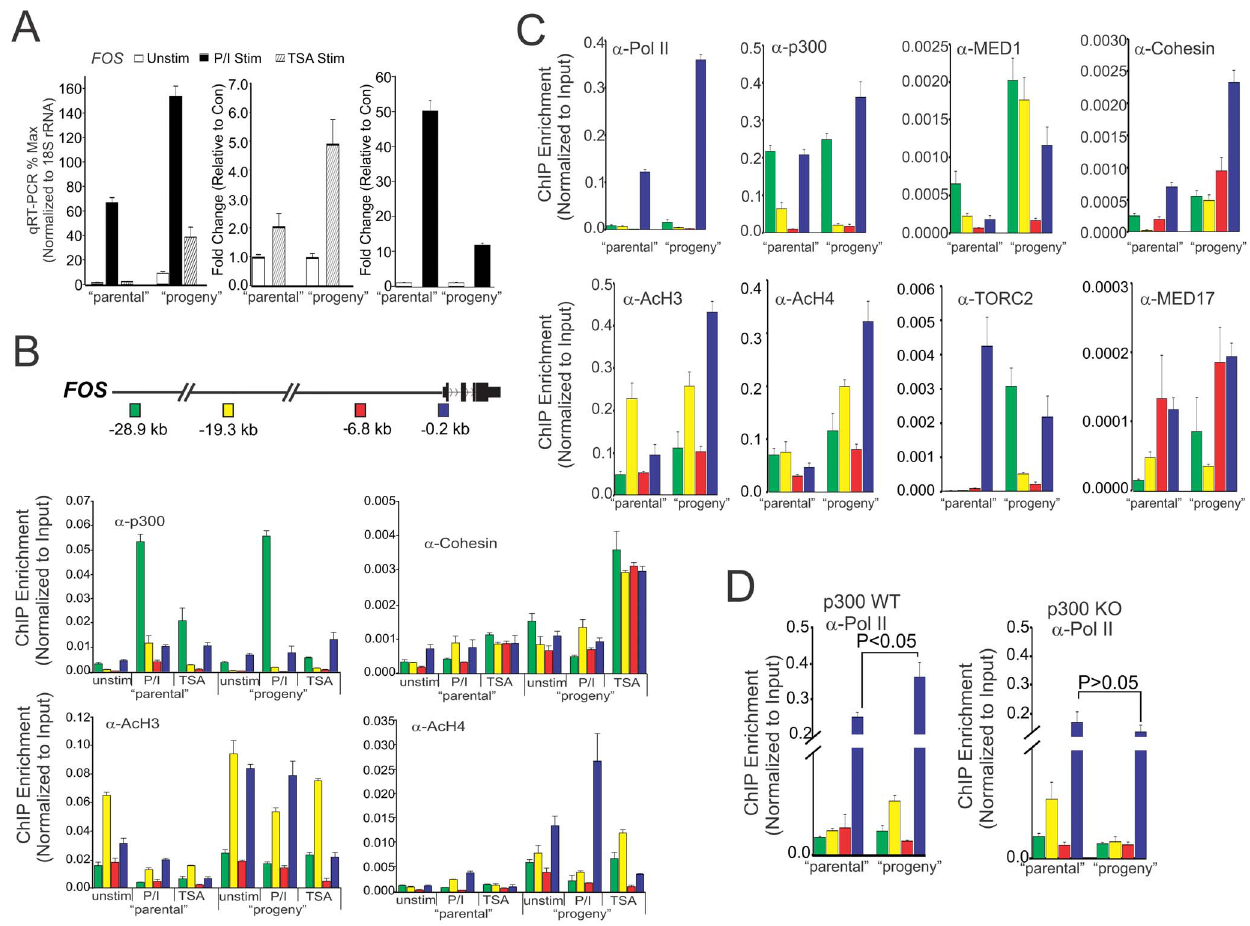
Figure 1. p300 facilitates parental trans-generational transmission of remembered states of potentiated transcriptional function. (A) Jurkat cells were treated with PMA and Ionomycin (P/I) for 1 h ‘‘parental’’. Cells were then washed and allowed to rest for 40 h. qRT-PCR profile showing FOS expression in resting Jurkat cells (‘‘parental’’) or Jurkat cells pre-treated with P/I (mitogen pulsed) for 1 h, washed, allowed to rest for 40 h (‘‘progeny’’) and restimulated with P/I (1 h) and TSA (2 h). The fold induction upon TSA stimulation (middle) or P/I stimulation (right) are presented as relative level compared to the amount present in the unstimulated population. (B) Position dependent profile of p300, Cohesin, acetylated histone H3 (AcH3) and acetylated histone H4 (AcH4) at the FOS locus of Jurkat cells as determined by quantitative ChIP analysis. Error bars represent standard error of the mean from 2 biological replicates each determined in duplicate. Shown above is a schematic of the locations of enhancers ( 2 28.9 kb & 2 19.3 kb), upstream ( 2 6.8 kb) and promoter ( 2 0.2 kb) at the FOS locus relative to TSS. (C) Position dependent profile at the FOS locus of Jurkat cells, relative to TSS, for indicated factors as determined by quantitative ChIP analysis. Error bars represent standard error of the mean from 2 biological replicates each determined in duplicate. (D) Position dependent profiles of pol II at the FOS locus in p300 WT and p300 KO in HCT 116 cells. Error bars represent standard error of the mean from 2 biological replicates, each determined in duplicate.